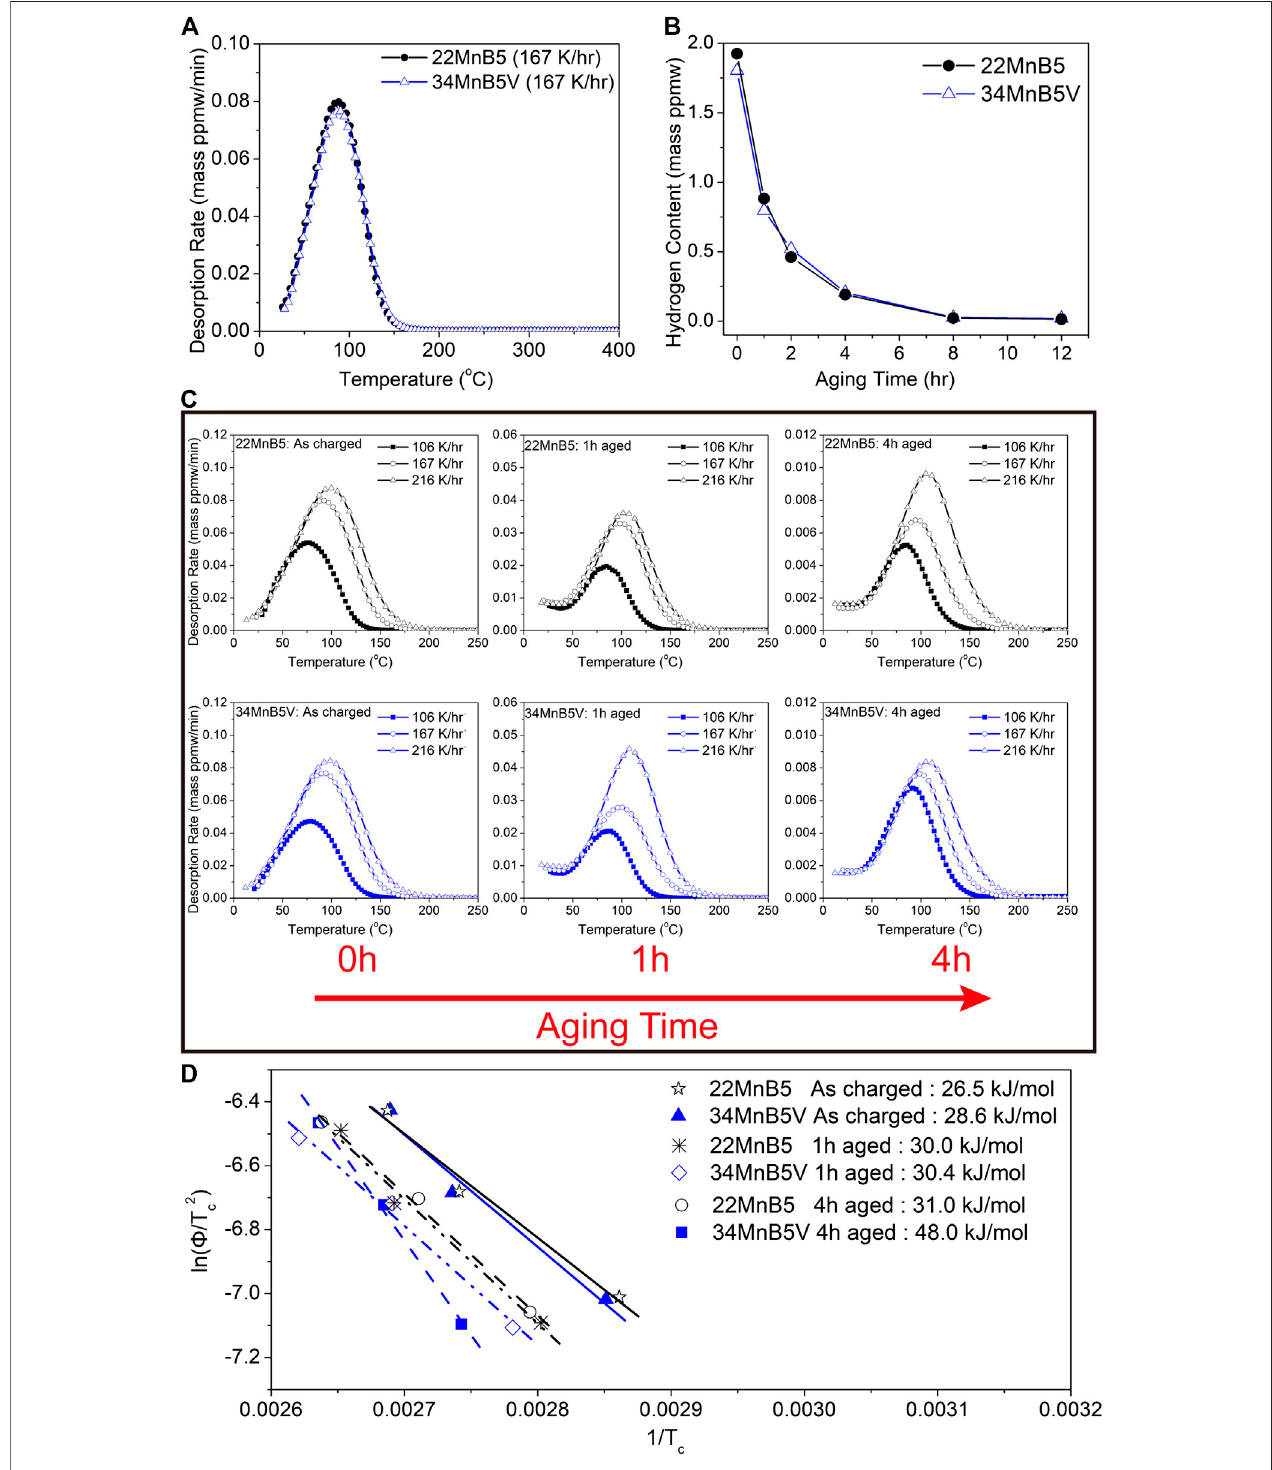
FIGURE6|(A) TDAofhydrogenatheatrateof150 K/h; (B) retainedhydrogenvs.agingtimeatroomtemperature; (C) TDAatdifferentheatingratesvs.agingtime at room temperature; (D) Cho and Lee analyses for activation energy.